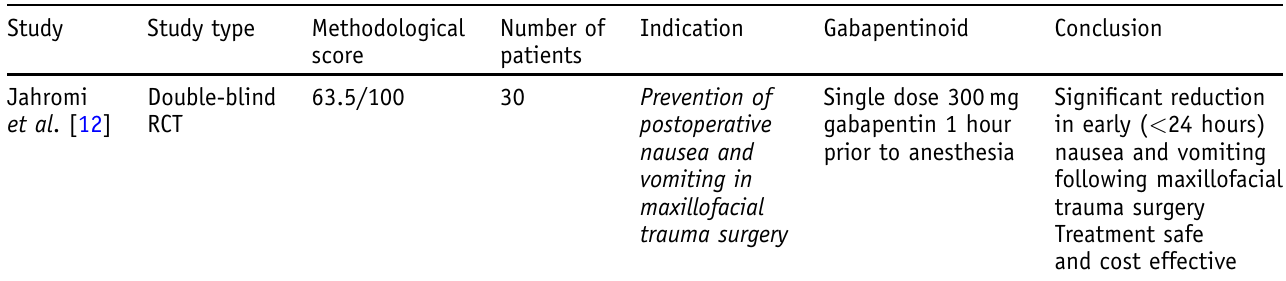
Table II. Scoping review results (cid:1) Gabapentinoids in the prevention of postoperative nausea and